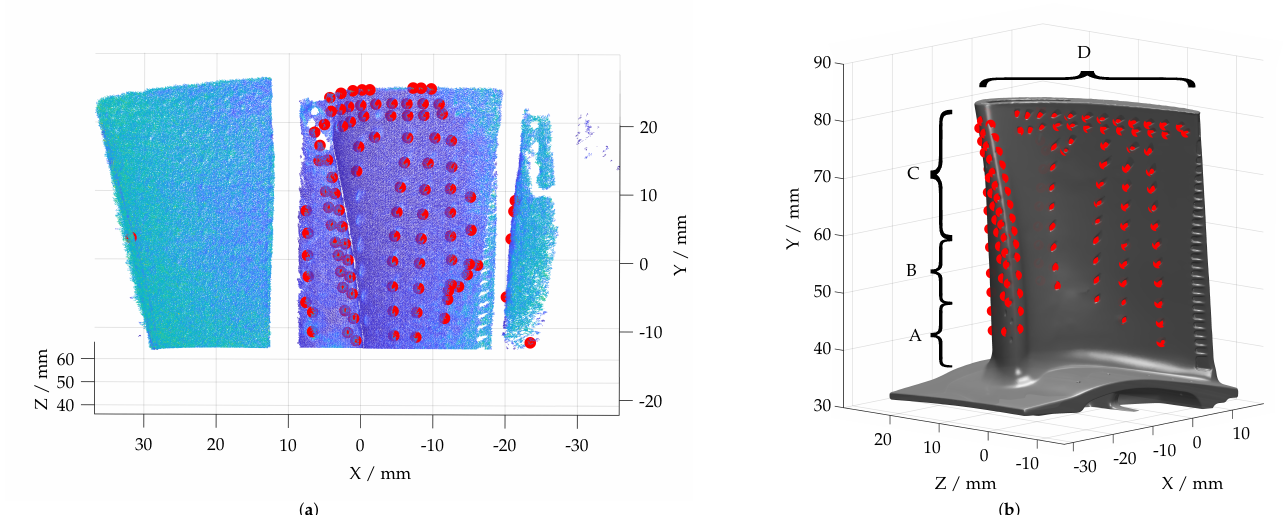
Figure 8. Detected film-cooling holes within borescopic measurement and reference geometry. ( a ) Film-cooling holes detected in the borescopic measurement. ( b ) Film-cooling holes detected in a reference measurement with a mapping of the inspection areas A–D from the engine